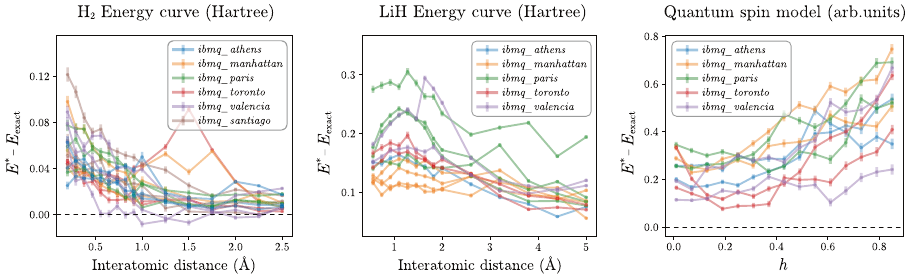
Fig. 6 Experimental data separated by IBM Quantum device. Final errors, E * − E exact , in repeated executions of VQE + BOIS ground state energy estimates for H 2 , LiH and the quantum spin model with the IBM Quantum device used indicated by plot colour. We do not observe any clear, systematic differences between the different devices. Error bars indicate standard error on fi nal energy